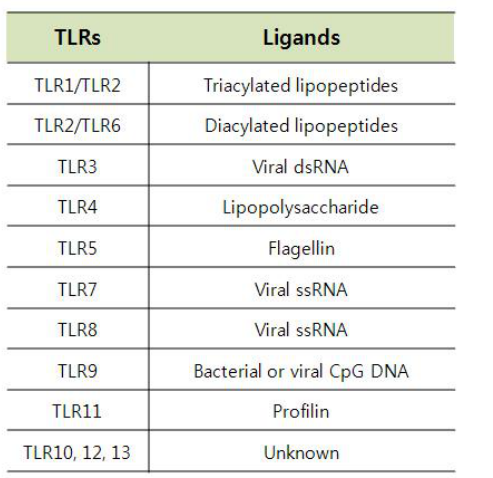
Table 2. TLRs and their